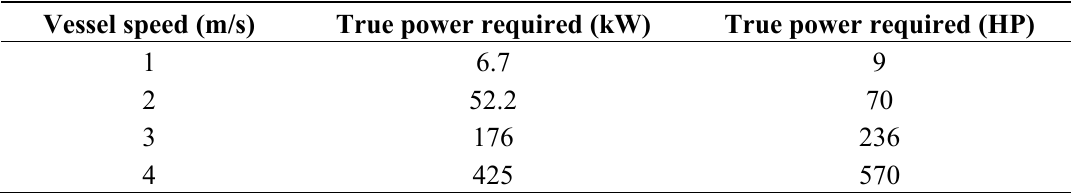
Table 4. Estimation of true propulsion power required depending on the vessel